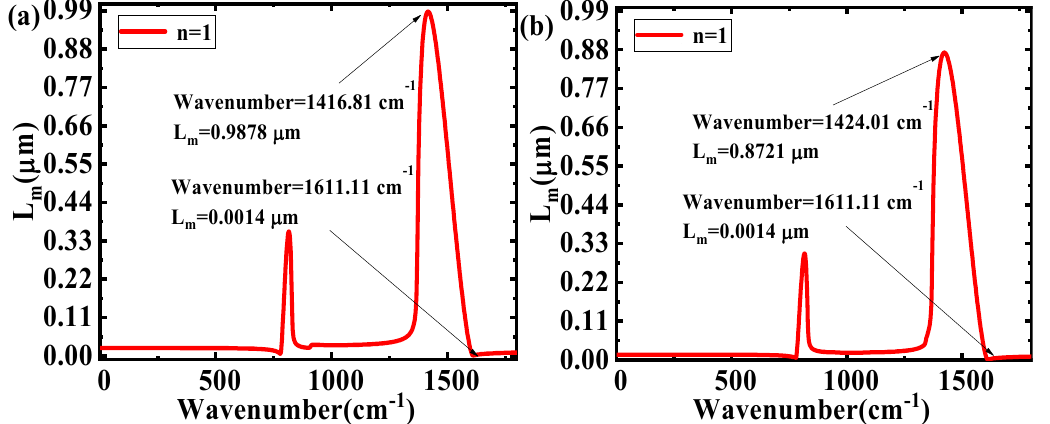
Figure 5. L m as a function of wavenumber in di ff erent ε 1 and ε 2 : ( a ) ε 1 = 1, ε 2 = 3.9, d = 50 nm; and ( b ) ε 1 = 1, ε 2 = 11.9, d = 50 nm.